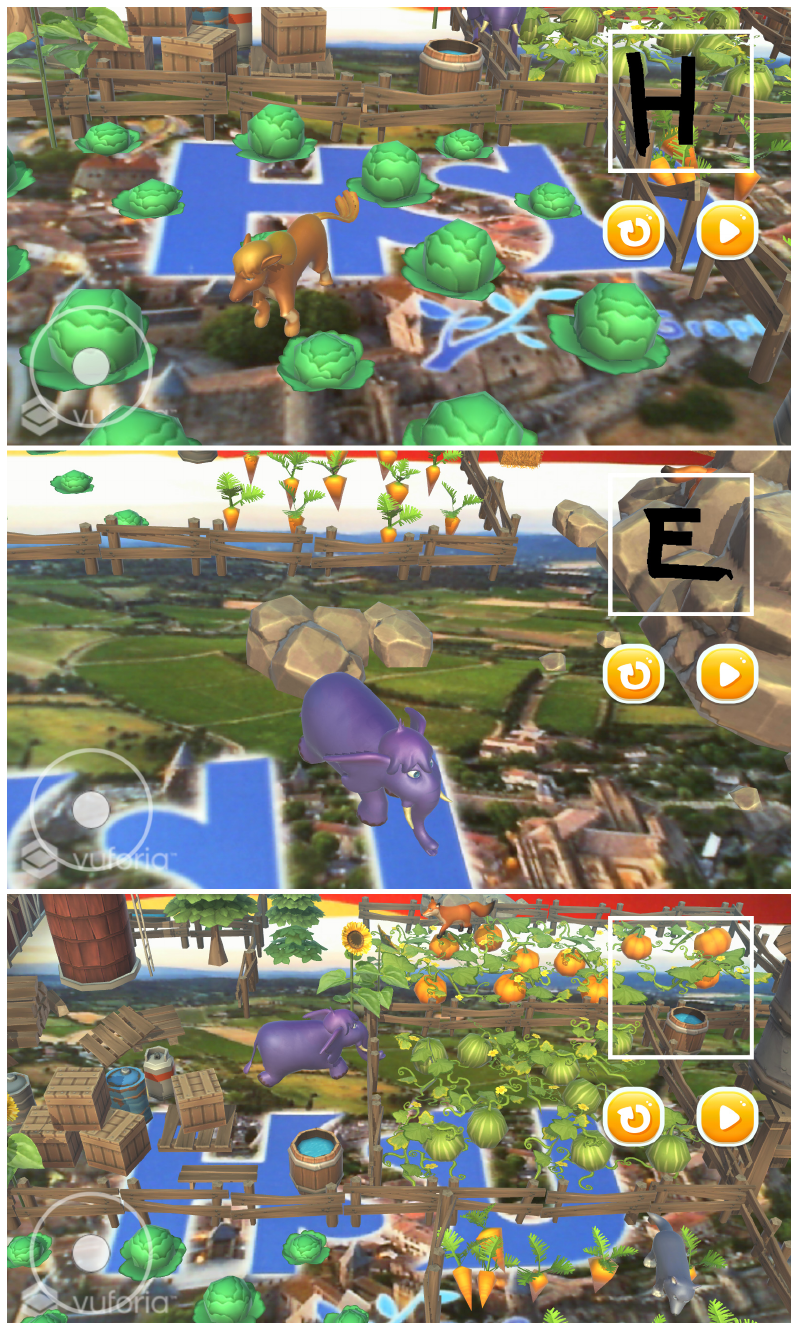
Figure 8. Production results of the AR application